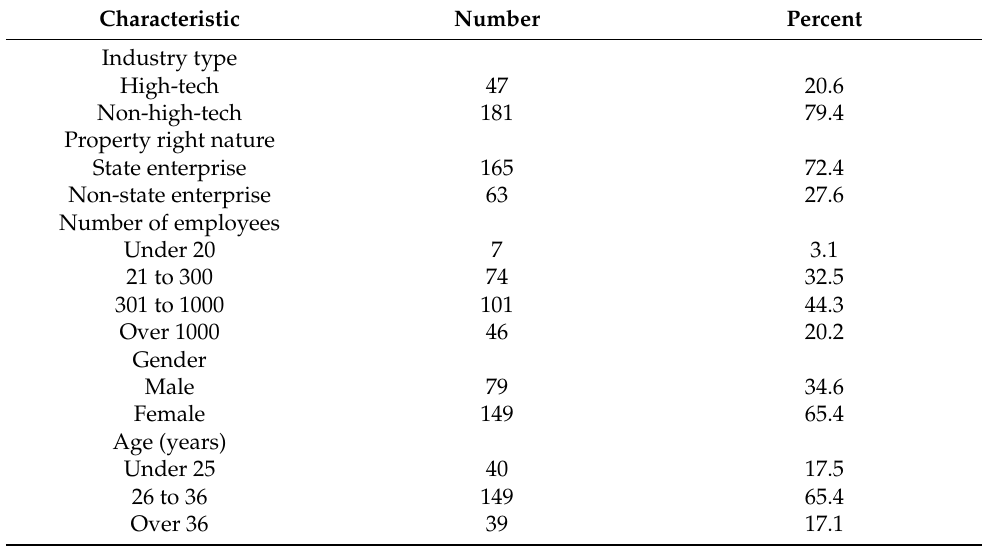
Table 1. Demographic characteristics of the